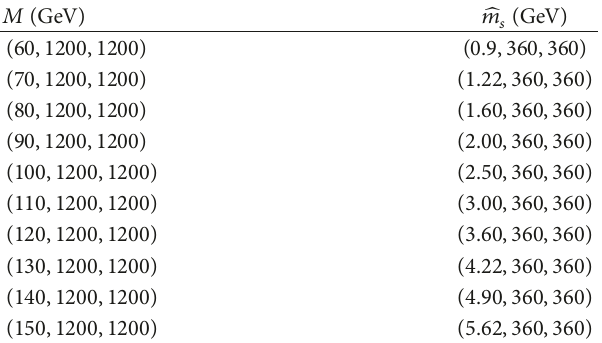
Table 1: Prediction of singlet fermion masses for different values of